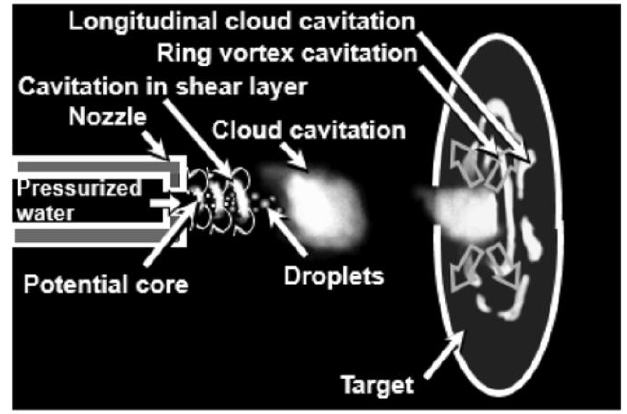
Figure 1. Principle of the WJP by submerged cavitating water jet.